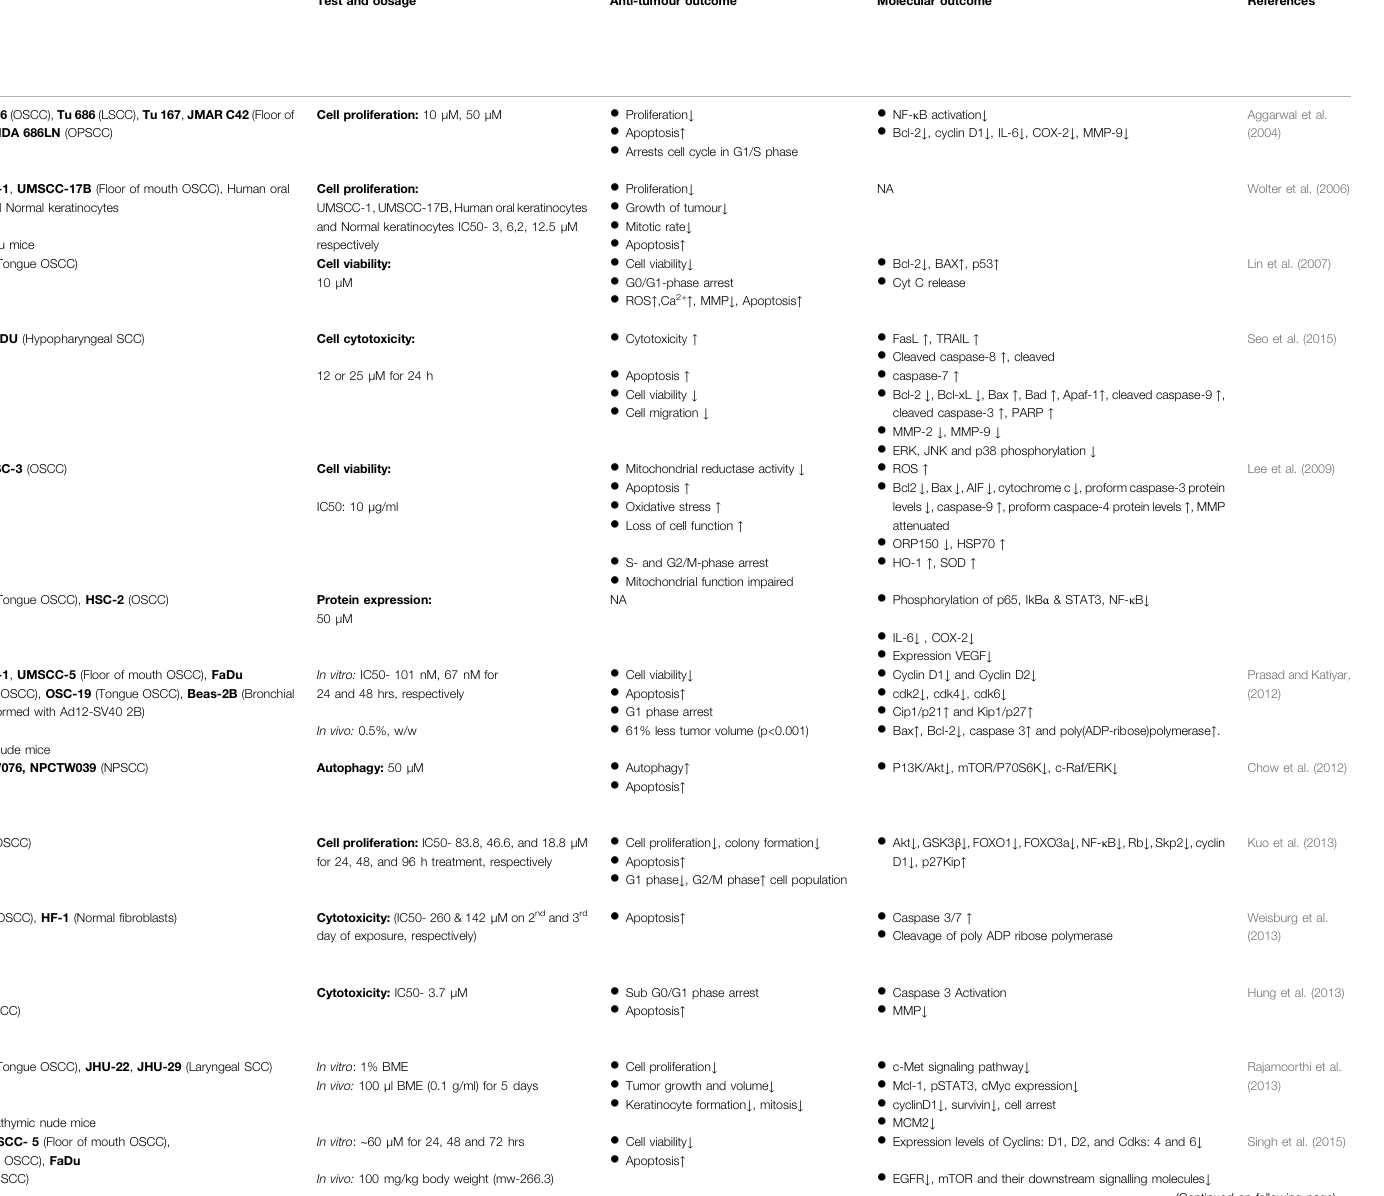
Rubus occidentalis